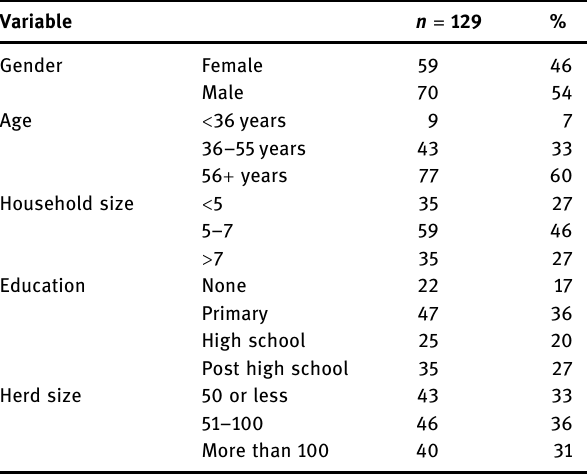
Table 2: Demographic characteristics of survey respondents Variable